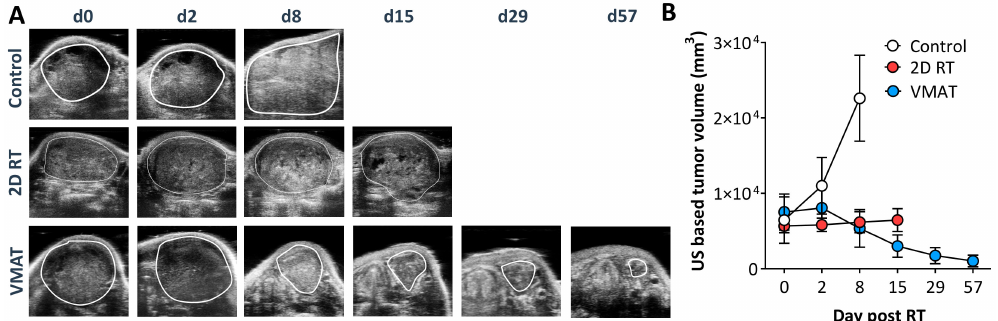
Figure 5. US-based monitoring of VX2 response to MR-guided VMAT. ( A ) Longitudinal B-mode US images of a representative animal from control, VMAT, and 2D RT groups. Tumor is outlined in white on all the images. Columns represent days post RT (d, days) ( B ) Corresponding tumor volume measurements at di ff erent time points post RT in VMAT, 2D-RT, and control cohorts. Animals treated by VMAT showed 85–100% reduction in tumor volume by Day 57. However, animals in 2D-RT cohort demonstrated steady increase in tumor volume and they were euthanized 14 days post RT due to significant